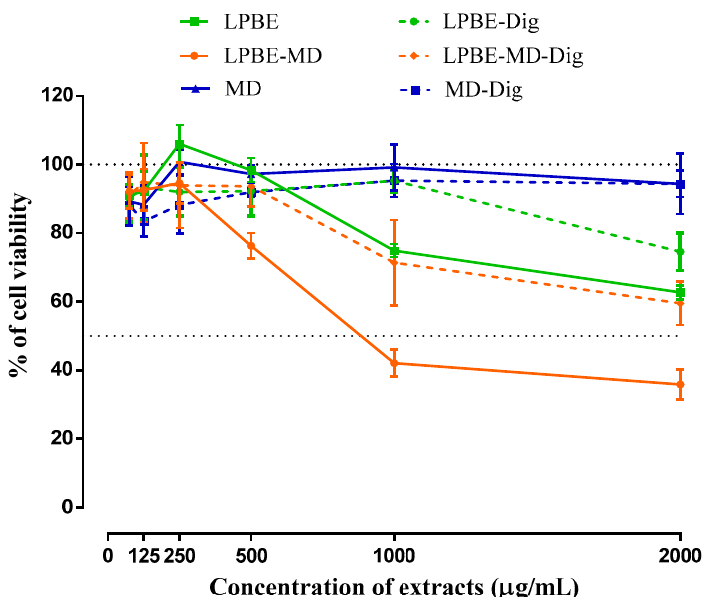
Figure 4. Cellular viability (%) of non-encapsulated (LPBE), encapsulated (LPBE-MD) PBE and maltodextrin (MD) as wall material before and after gastrointestinal digestion against human colorectal adenocarcinoma Caco-2 cells.